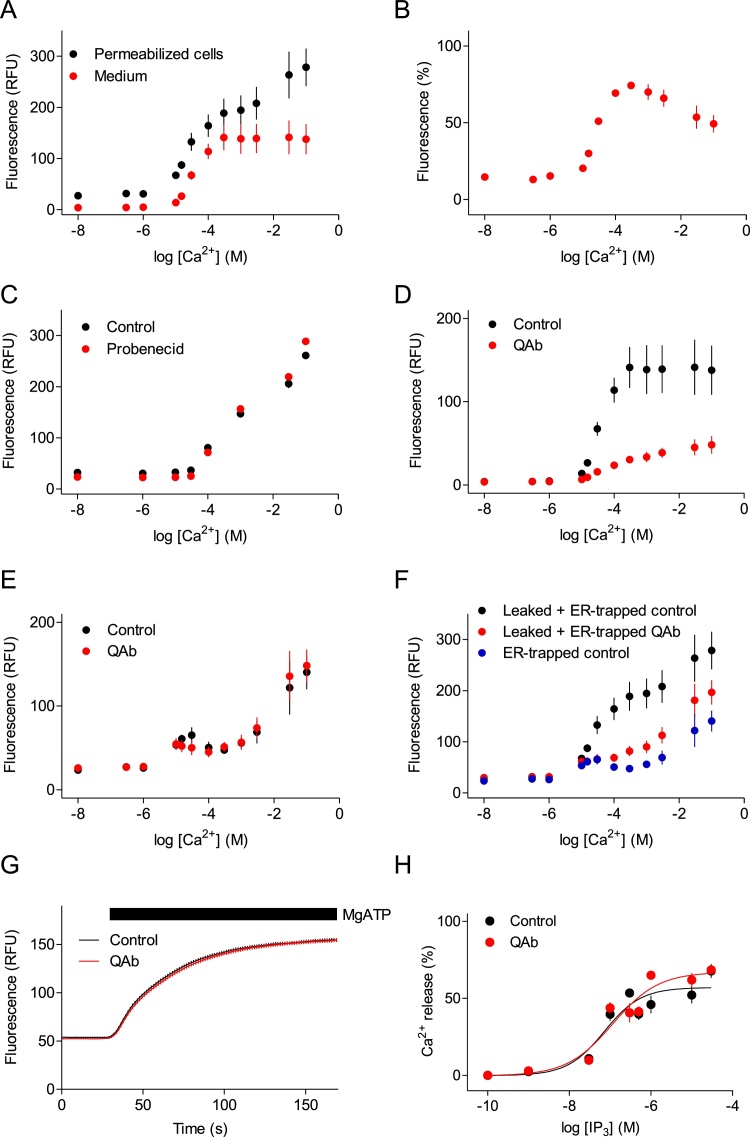
Fluorescence from leaked Mag-Fluo-4 is quenched by QAb. (A) Permeabilized HEK cells loaded with Mag-Fluo-4 AM were re-suspended in CLM-H (i.e. CLM supplemented with HEDTA to provide effective buffering of high free [Ca2+]), with the indicated [Ca2+]m and CPA (10 μM). We note that with the prolonged incubations used (5-20 min), luminal [Ca2+] and [Ca2+]m equilibrate without the need for ionomcyin to accelerate equilibration (see Fig. 3A). Results (means ± SEM, n = 3 independent experiments each with duplicate determinations) show parallel analyses of the medium alone (after removal of cells by centrifugation, Fmedium) or cells in the medium (Fpermeabilized cells). (B) Results from panel A were used to estimate the contribution of leaked indicator to total fluorescence intensity (Fmedium/Fpermeabilized cells, %) at each [Ca2+]m. (C) Fluorescence recorded from permeabilized cells after treatment with probenecid (2.5 mM). Means ± SD from a single experiment, typical of two experiments, each with duplicate determinations. (D) Effects of QAb (1:20) on Ca2+-dependent changes in fluorescence from leaked Mag-Fluo-4 (Fmedium). Means ± SEM, n = 3 independent experiments, each with duplicate determinations (control trace reproduced from panel A). (E) Comparison of the responses of trapped Mag-Fluo-4 (Fpermeabilized cells - Fmedium) to changes in [Ca2+]m in the absence or presence of QAb (1:20). Means ± SEM, n = 3 independent experiments, each with duplicate determinations. (F) Effects of QAb (1:20) on Ca2+-dependent changes in fluorescence from permeabilized cells together with their medium (Fpermeabilized cells), or from trapped indicator alone (Fpermeabilized cells - Fmedium) in the absence of QAb. Means ± SEM, n = 3 independent experiments each with duplicate determinations (blue symbols reproduced from panel E). The results confirm that most fluorescence from leaked indicator is quenched by QAb. (G) Ca2+ uptake by permeabilized cells loaded with Mag-Fluo-4 AM and incubated in CLM with free [Ca2+]m = 300 nM was stimulated by addition of ATP (1.5 mM). QAb (1:20) had no effect on the response. (H) Concentration-dependent effects of IP3 on Ca2+ release from permeabilized HEK cells in CLM with 300 nM [Ca2+]m. QAb (1:20) had no effect. To minimize use of costly QAb, results in G and H (means ± SD) are from a single experiment with 3 replicates.